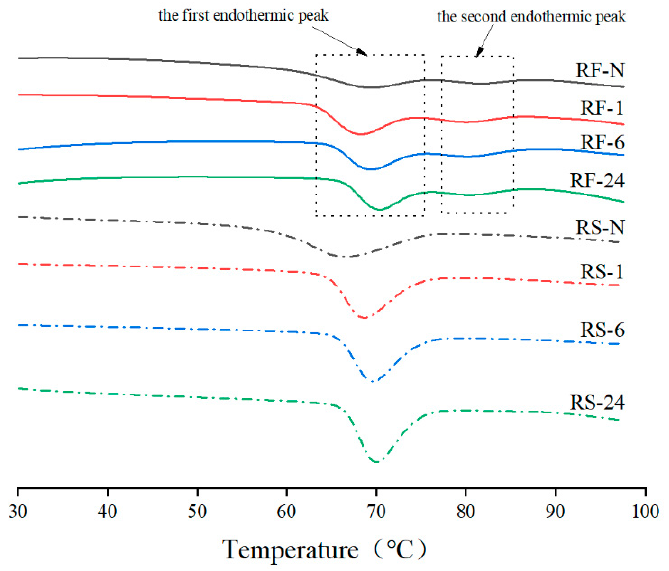
Figure 4. Differential scanning calorimetry (DSC) curves of native and partially hydrolyzed RF and RS. RF represents rice flour and RS represents rice starch; numbers refer to the hydrolysis time (hours); RF-N is native rice flour and RS-N is native starch isolated from rice flour. The two endothermic peaks of the RF group were pointed out. Table 5. The DSC parameters 1 of native and partially hydrolyzed RF (the first endothermic peak) and RS.